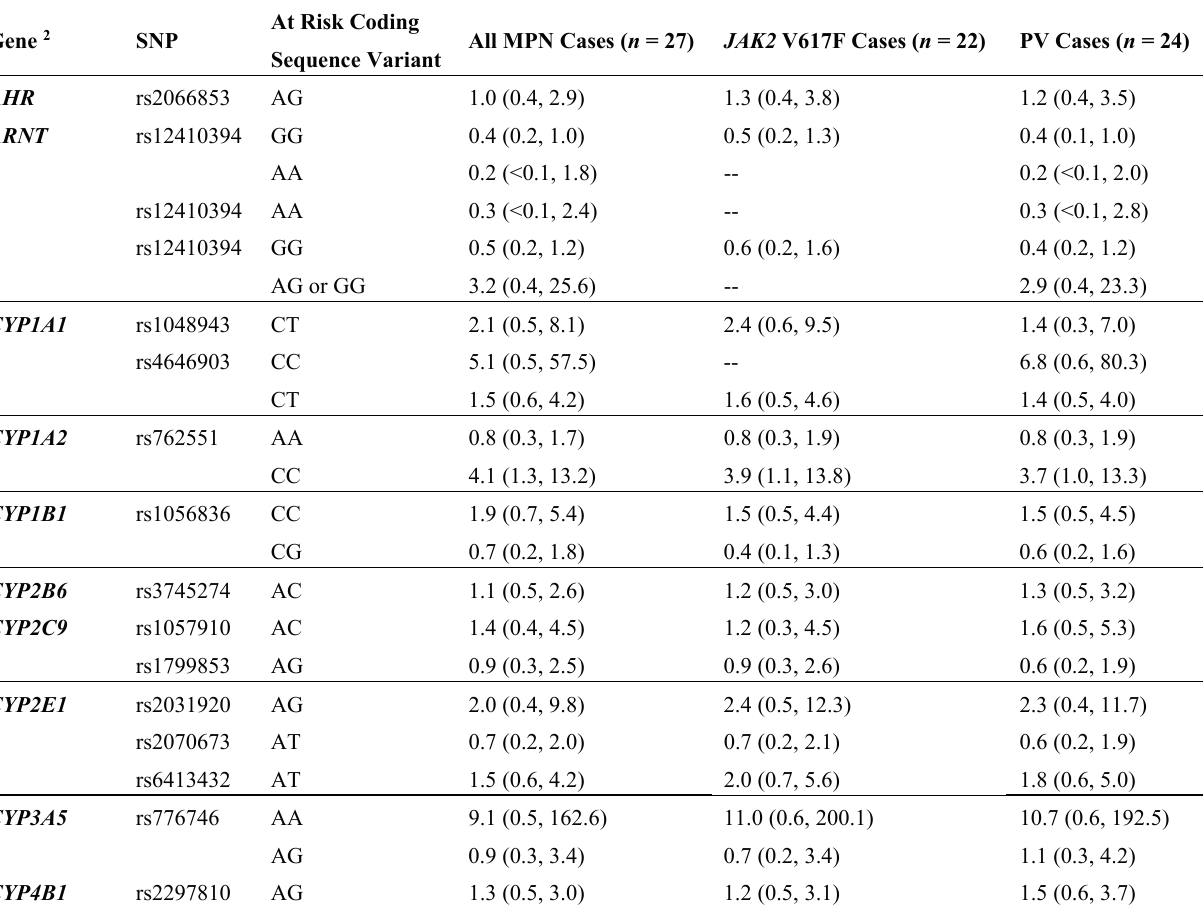
Table 3. Association of myeloproliferative neoplasm with environmentally sensitive gene in case-control analysis: Odds ratios and (95% confidence intervals), adjusted for age, sex, and county 1